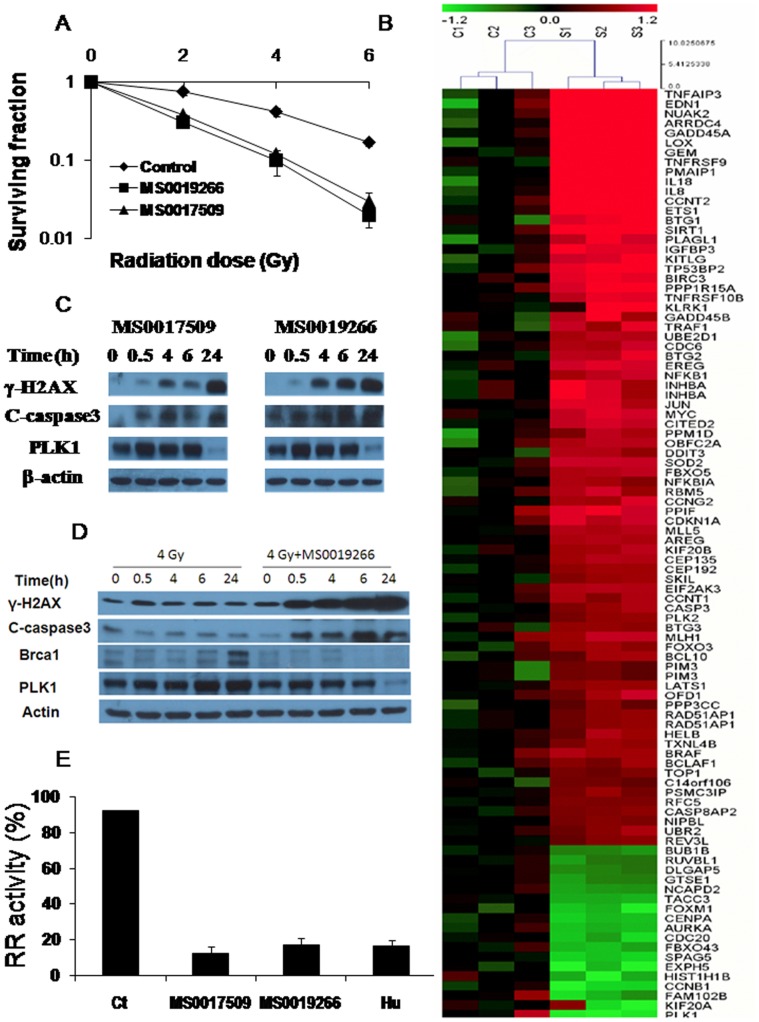
MS0019266 and MS0017509 enhance tumor cell radiosensitivity and specifically targets ribonucleotide reductase and polo-like kinase 1.A) Colony formation assay performed on DU145 cells. Pretreatment with MS0019266 and MS0017509 (1 µM for 72 hours) significantly reduced clonogenic survival in DU-145 prostate cancer cells subsequently treated with ionizing radiation administered 24 hours after drug administration. Following 72 hours of drug treatment, cells were switched to drug free media. Results are the average of experiment and each experiment was done in triplicate (n = 3). * denotes p<0.05 and ** denotes p<0.01 vs. vehicle control. B) Gene expression changes following treatment with MS0019266 as assessed by gene expression microarray. Genes showing differential expression between MS0019266 (5 µM for 8 hours) treated cells and vehicle treated controls. Upregulated genes are shown in red and downregulated genes are shown in green. C) γ-H2AX cleaved, caspase3 and PLK1 expression were examined by immunoblotting. Administration of MS0019266 (10 µM) and MS0017509 (10 µM) for 4 hours resulted in significant accumulation of γ-H2AX and cleaved caspase3 over time in DU-145 cells. In contrast, PLK1 is markedly decreased at 24 hours after drug treatment. D) Combined treatment with MS0019266 (10 µM for 4 hours) and ionizing radiation resulted in more significant accumulation of γ-H2AX compared to either MS0019266 or radiation alone. PLK1 is also markedly decreased at 24 hours after combined treatment with radiation and MS0019266. Further, treatment of irradiated cells with MS0019266 (10 µM for 4 hours) markedly reduced the accumulation of radiation-induced BRCA1 repair protein at 6 and 24 hours following ionizing radiation. E) MS0017509 and MS0019266 are potent inhibitors of in vitro ribonucleotide reductase activity. Administration of MS0019266 (10 µM) and MS0017509 (10 µM) for 6 hours prior to CDP assay resulted in a similar reduction of ribonucleotide reductase activity as hydroxyurea (200 µM) in treated DU-145 cells.